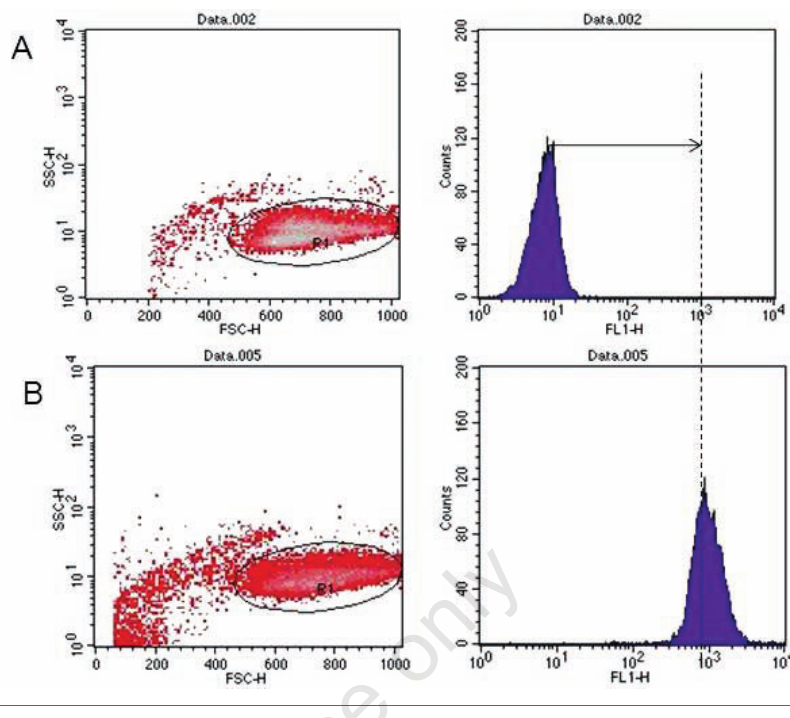
Figure 1. Flow cytometric analysis of DiO-labeled target cells. (A) Negative control (left peak). (B) DiO positive events identified (right peak).